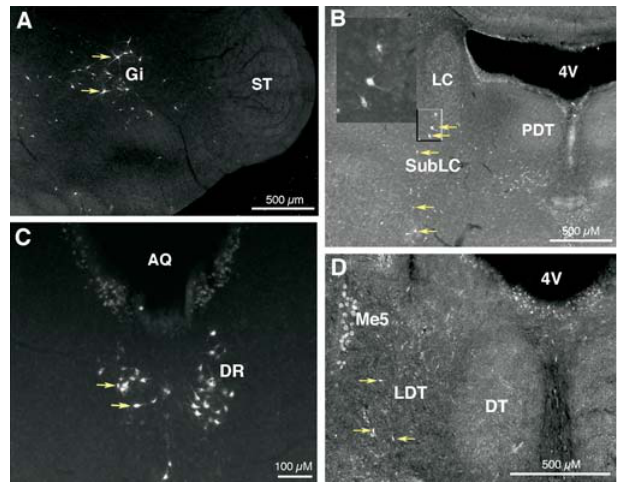
Figure 2. Representative Labeling of Cell Bodies in Selected Areas after a DiI Infusion into the Medullary Inhibitory Area The arrows indicate examples of labeled neurons in (A) nucleus gigantocellularis (Gi), (B) subcoeruleus (SubLC), (C) dorsal raphe´ (DR), and (D) laterodorsal tegmental nucleus (LDT). Inset in (B) depicts enlarged view of the boxed area. 4V, fourth ventricle; AQ, cerebral aqueduct; DT, dorsal tegmental nucleus; Me5, mesencephalic trigeminal nucleus; ST, spinal trigeminal nucleus DOI: